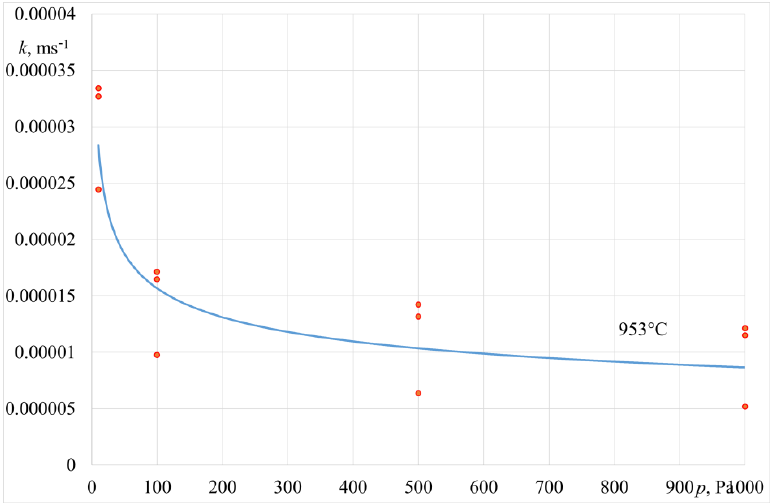
Figure 9. Variation of overall mass transfer coefficient k Zn vs. pressure (induction furnace with a cold crucible).